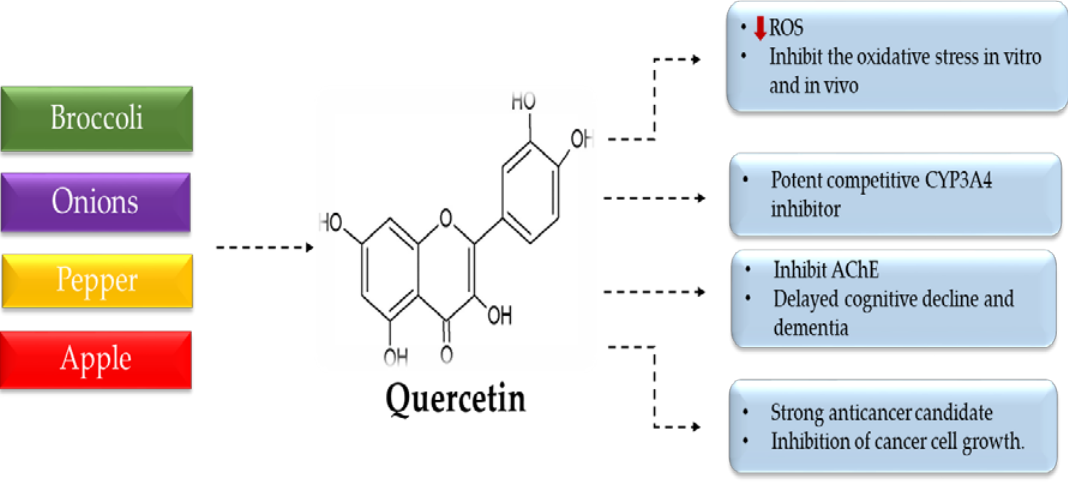
Figure 2. The pharmacological activity of